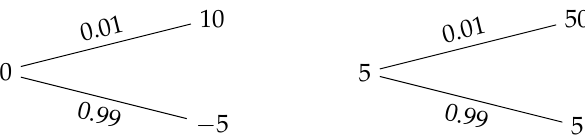
Figure 2. Evolution of the VaR between times t = 0 and 1 (Example 1). Left : evolution for X . Right : evolution for Y .